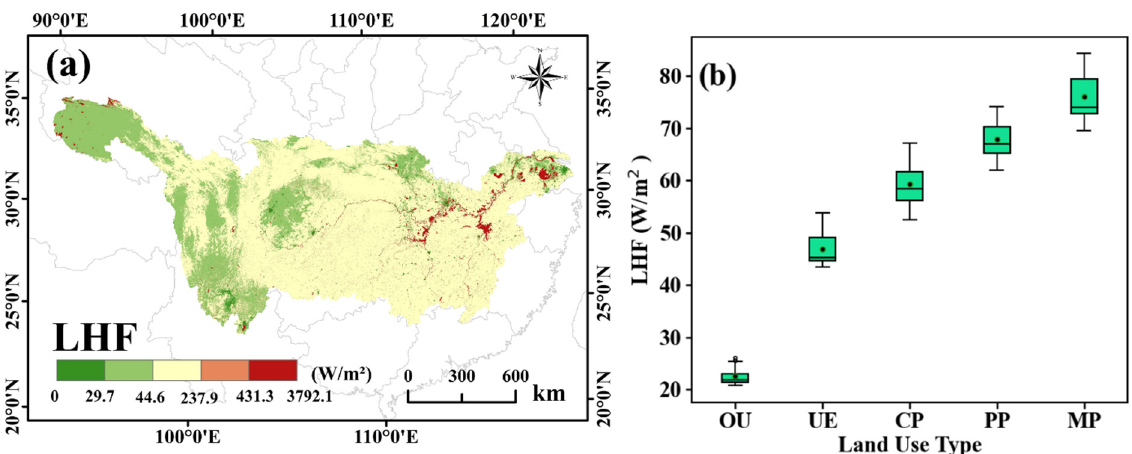
Figure 8. ( a ) spatial variation of latent heat flux (LHF) and ( b ) statistical values for the five land use types in the Yangtze River basin from 2000 to 2020.